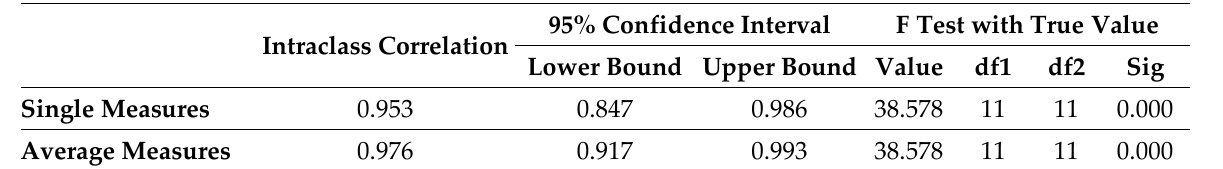
Table 4 Intraclass Correlation Coefficient.